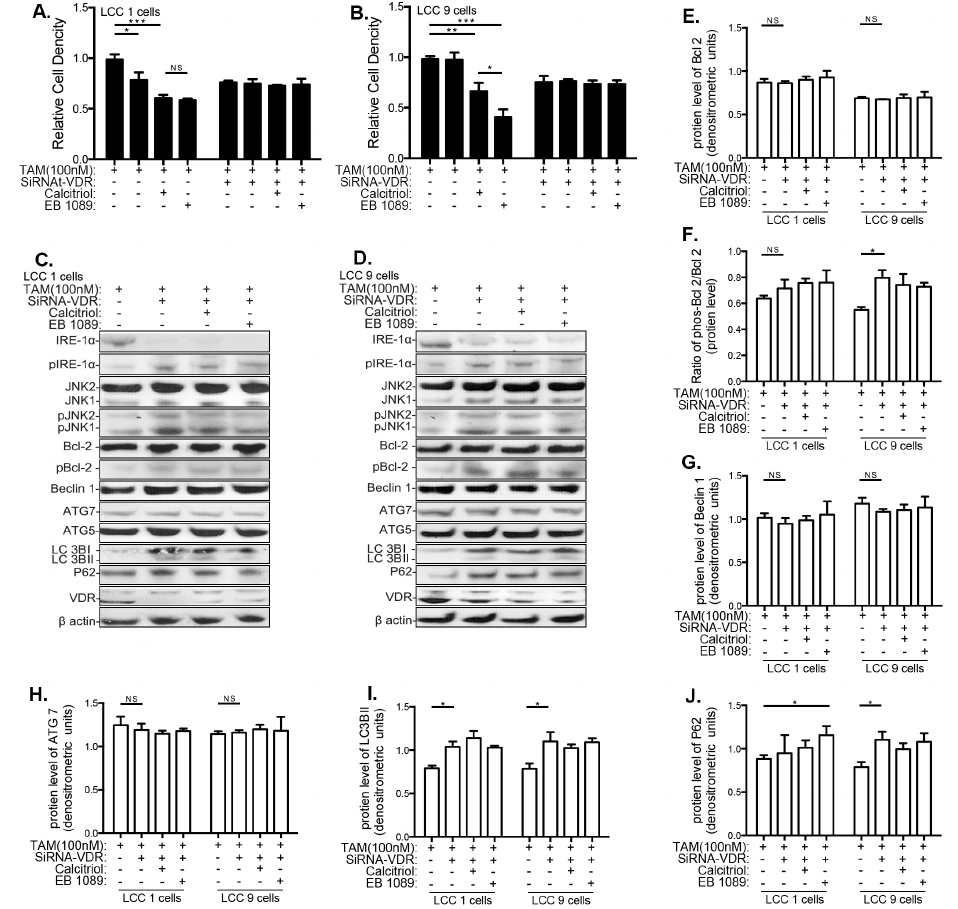
Figure 6. Silencing VDR blocks the response of breast cancer cells to TAM and VitD. siRNA-VDR- transfected LCC1 ( A ) or LCC9 ( B ) cells were treated with TAM (100 nM) plus either vehicle (ethanol), calcitriol (100 nM) or EB1089 (100 nM) for 3 days, respectively. Relative cell density was determined by crystal violet assay. Representative Western blots of autophagy-linked genes in ( C ) LCC1 cells and ( D ) LCC9 cells treated as described above. Quantification of protein expression of ( E ) total Bcl-2, ( F ) the ratio of pBcl-2 over total Bcl-2, ( G ) Beclin 1, ( H ) Atg7, ( I ) LC3BII, and ( J ) p62 based on three independent replications using β -actin as a loading control. TAM treatment. * p < 0.05; ** p < 0.01, *** p < 0.001. NS: not significant. Means ± standard error of means are